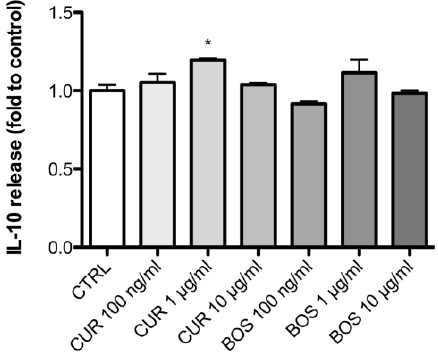
Figure 3. IL-10 release in PBMC after 24 h of incubation with CUR and BOS. * p < 0.05 vs. control.